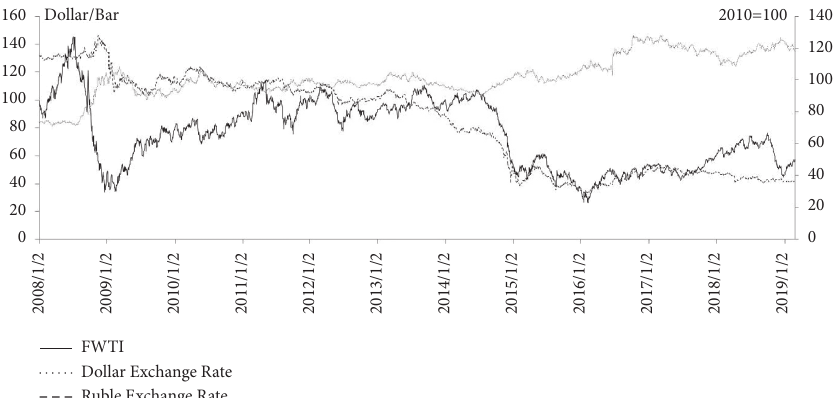
Figure 6: Relation between crude oil future prices, dollar exchange rate, and ruble exchange rate.